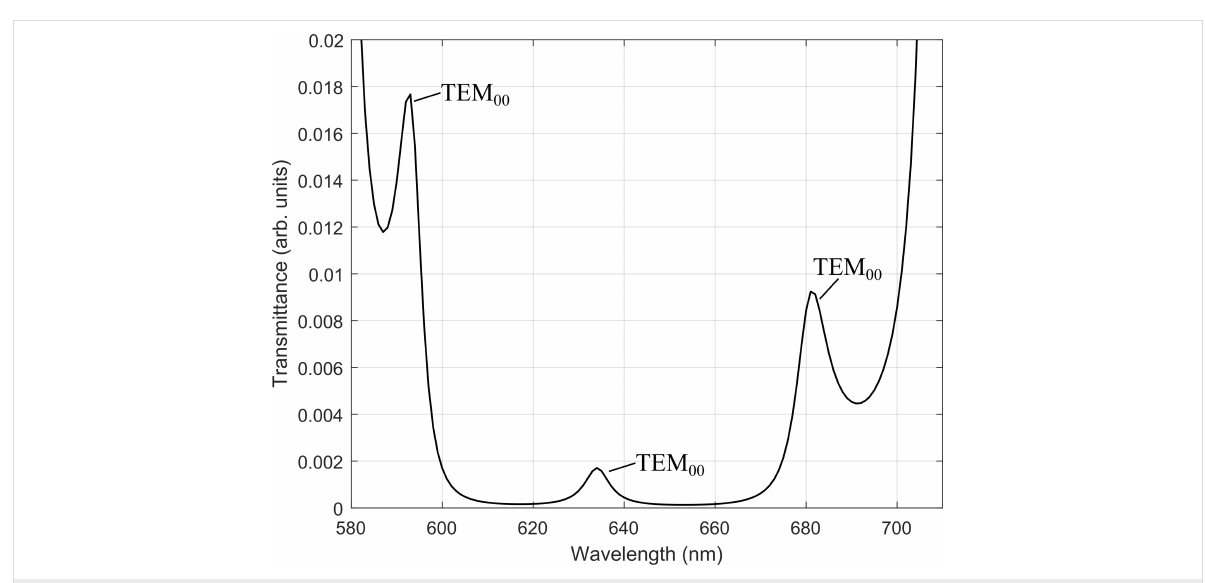
Figure 7: Transmittance of plano-concave cavity shows the fundamental TEM modes at 595 nm, 636 nm and 684 nm.